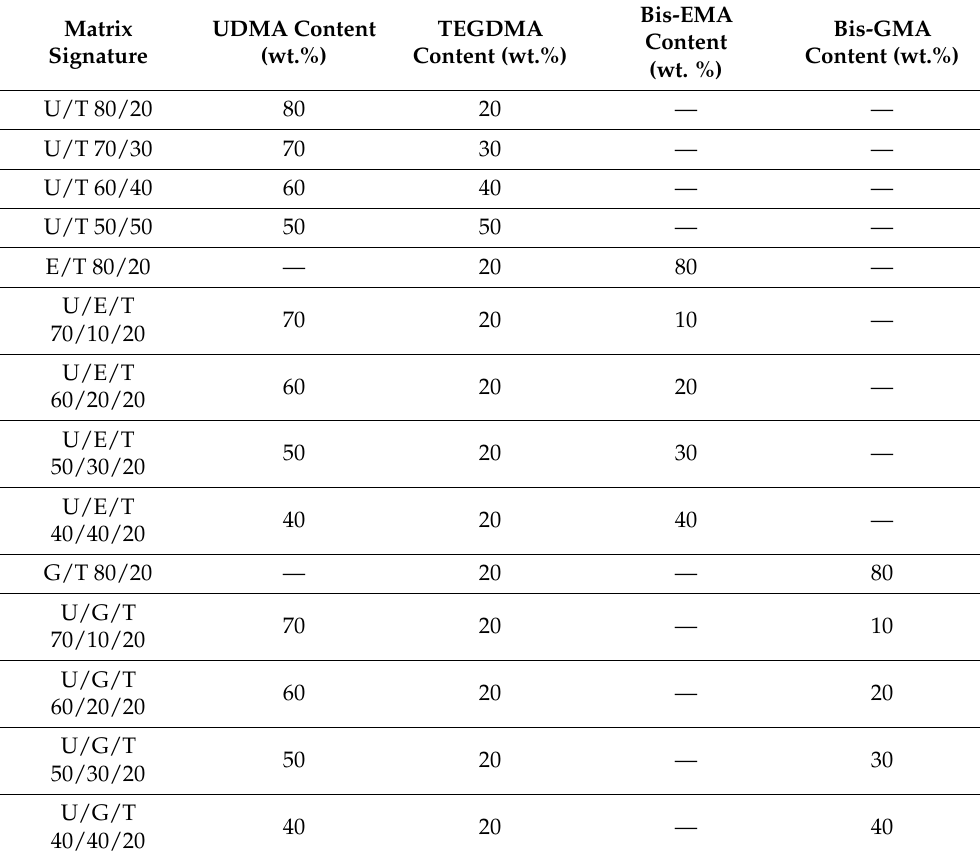
Table 3. Composition of tested